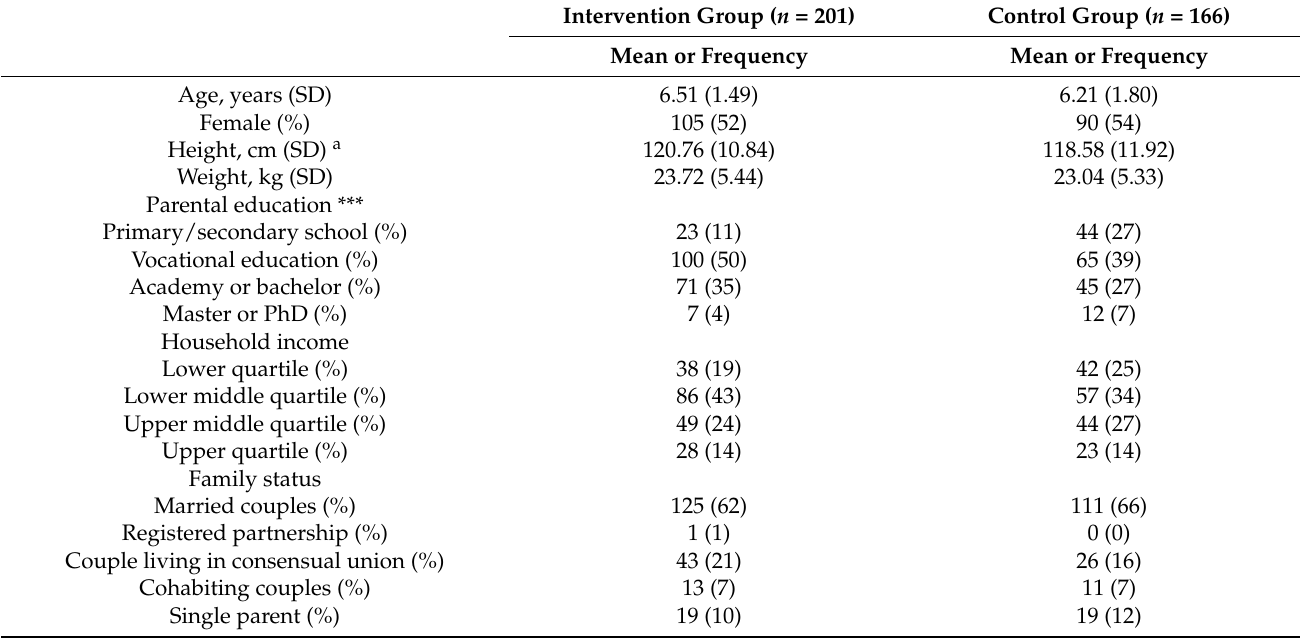
Table 1. Child baseline characteristics.